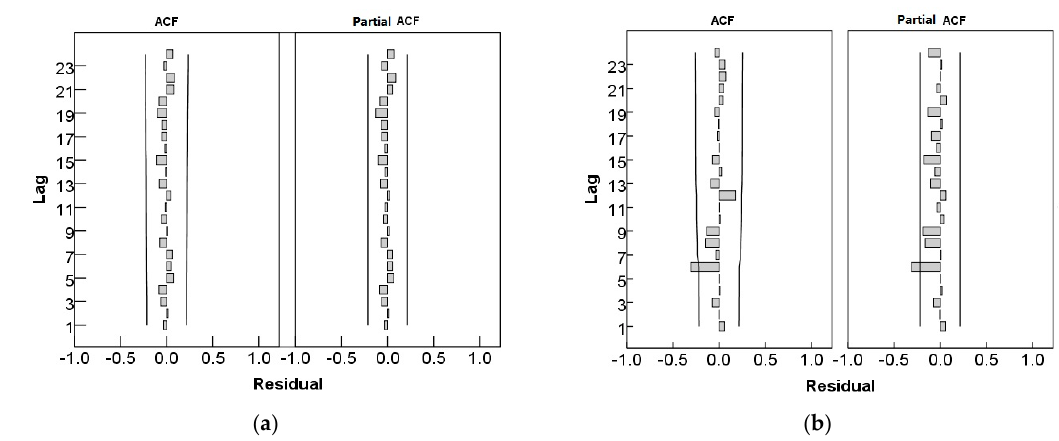
Figure 10. ACF and Partial ACF of ARIMA model: ( a ) Runoff; ( b ) Sediment.